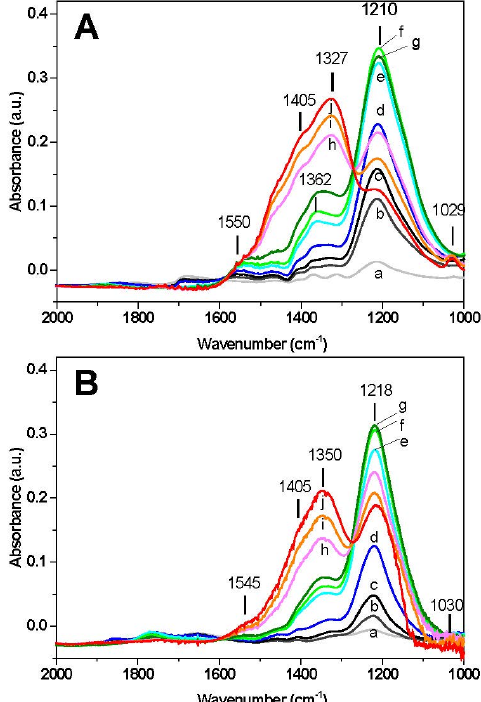
Figure 2. Operando FT ‐ IR spectra recorded during NO ‐ TPR experiments with NO (1000 ppm) in He over Rh ‐ BaO/Al 2 O 3 ( A ) and Pt ‐ BaO/Al 2 O 3 ( B ) from 50 to 350 °C (10 °C/min), spectra recorded every 1 min, displayed at selected temperatures: ( a ) 50 °C; ( b ) 100 °C; ( c ) 120 °C; ( d ) 150 °C; ( e ) 200 °C; ( f ) 220 °C; ( g ) 250 °C; ( h ) 300 °C; ( i ) 320 °C; ( l ) 350 °C (rig#2).